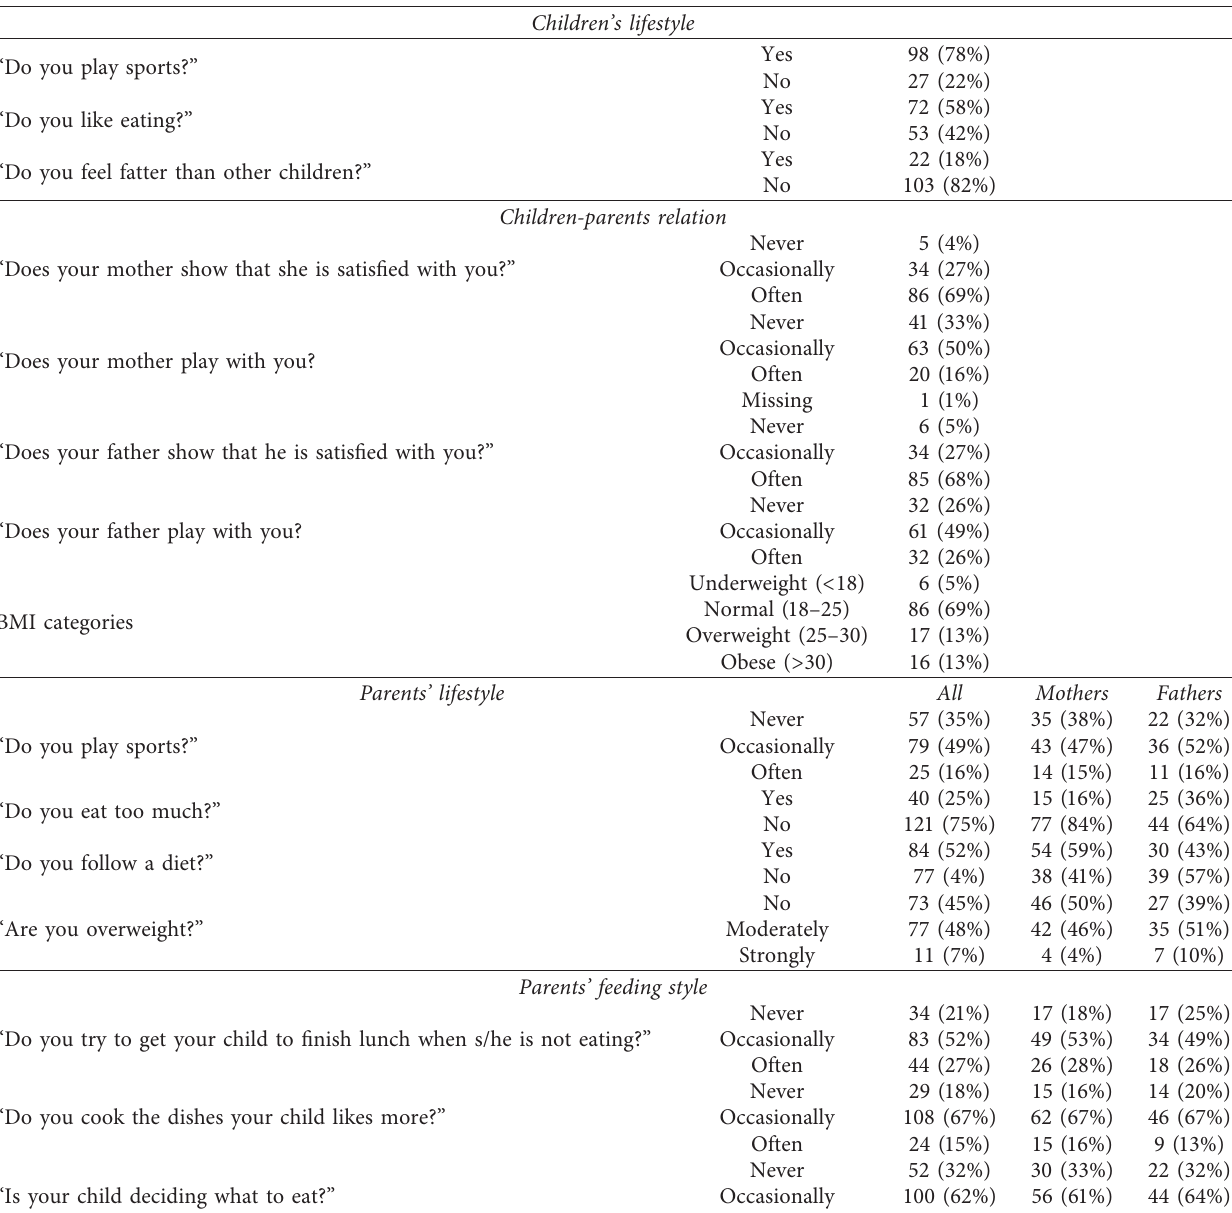
Table 2: Frequencies and percentages of anthropometric data lifestyle, food attitude, and parental relations of the children ( n � 125) and frequencies and percentages of lifestyle (sports, diet and overweight) and feeding style of parents ( n � 161). Children’s body mass index (BMI) categories are also